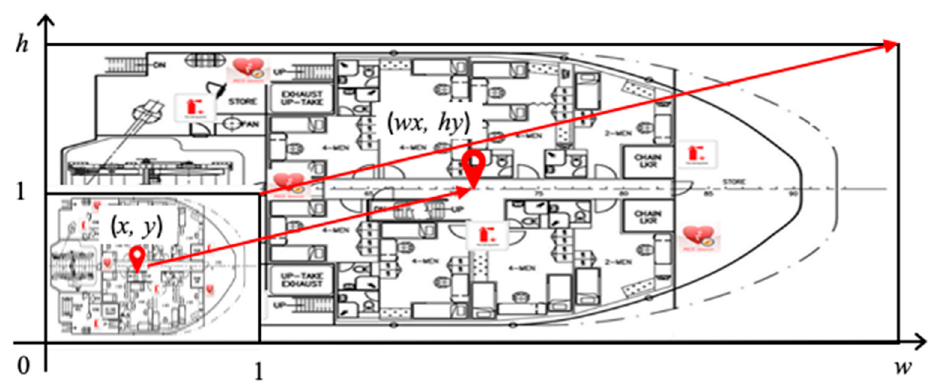
Figure 8. RHLS scaling function.